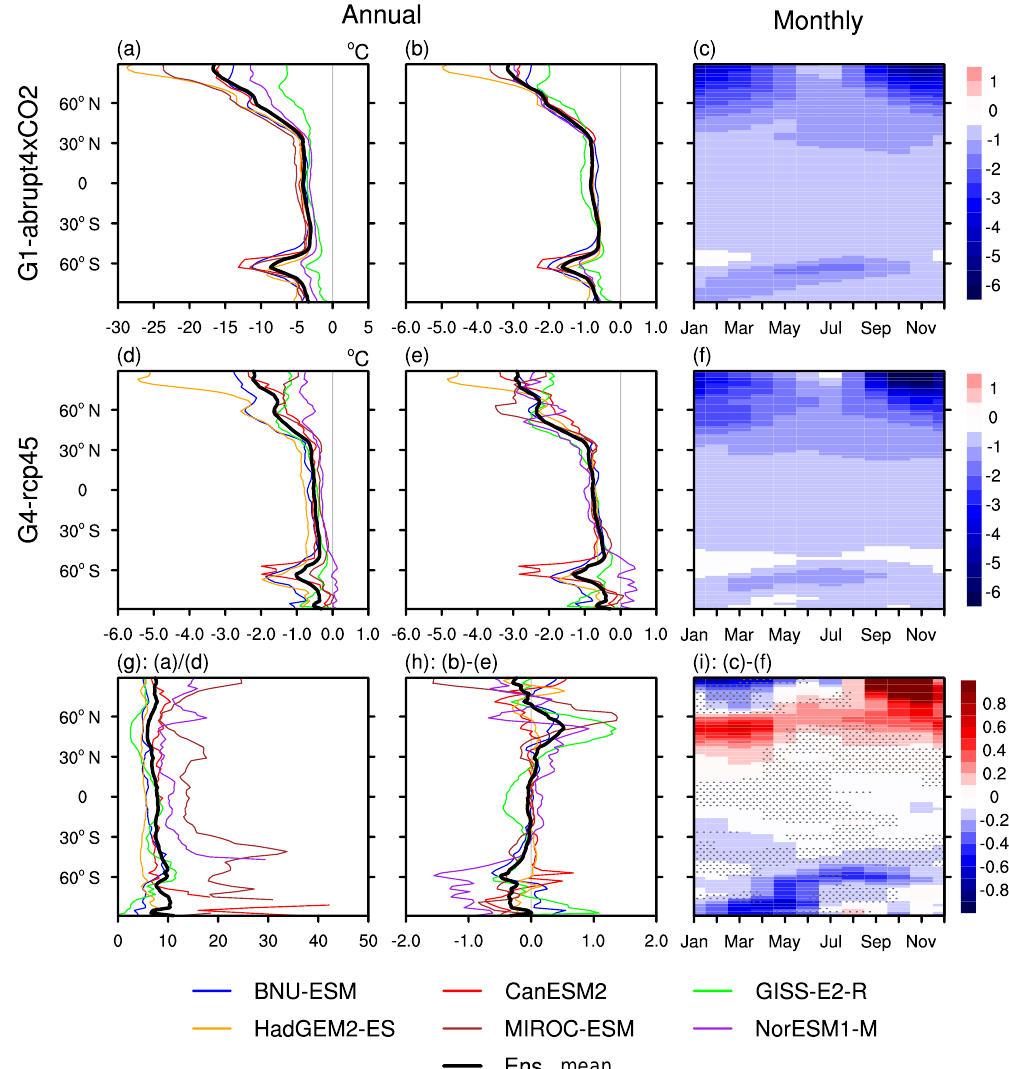
Figure 6. Absolute difference in annual zonal mean in the extreme low temperature TNn (a, d) . Normalized difference with respect to annual zonal mean (b, e) and monthly zonal mean (c, f) in TNn: (a, b, c) G1 − abrupt4 × CO2, (d, e, f) G4 − rcp45, (g) the ratio between absolute G1 − abrupt4 × CO2 and G4 − rcp45, (h) the annual zonal mean difference between normalized G1 − abrupt4 × CO2 and G4 − rcp45, and (i) the monthly zonal mean difference between normalized G1 − abrupt4 × CO2 and G4 − rcp45 taken over the 40-year analysis period. In panel (i) , red colours indicate relatively greater changes with G4 and blue colours indicate this with G1; stippling indicates regions where fewer than five of six models agree on the sign of the model response. Three by three point smoothing was applied to the seasonal latitude